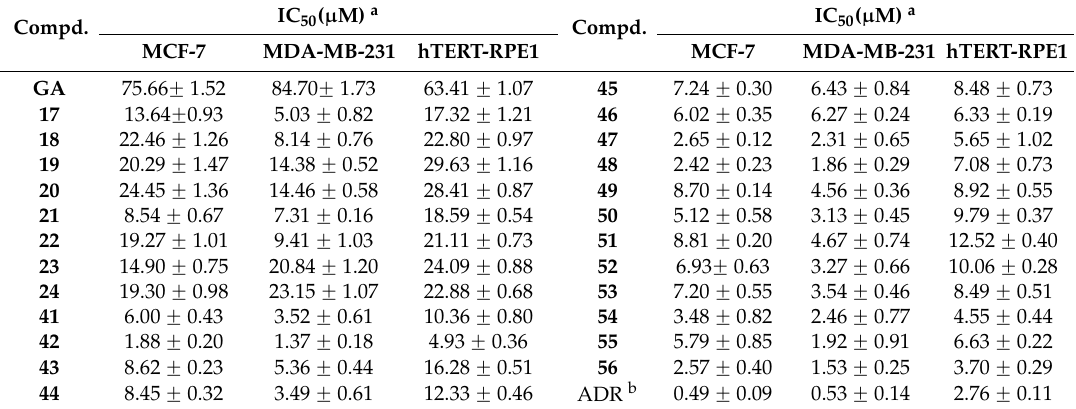
Table 1. IC 50 values (in µ M) of test compounds against MCF-7, MDA-MB-231 and hTERT-RPE1 cell lines.